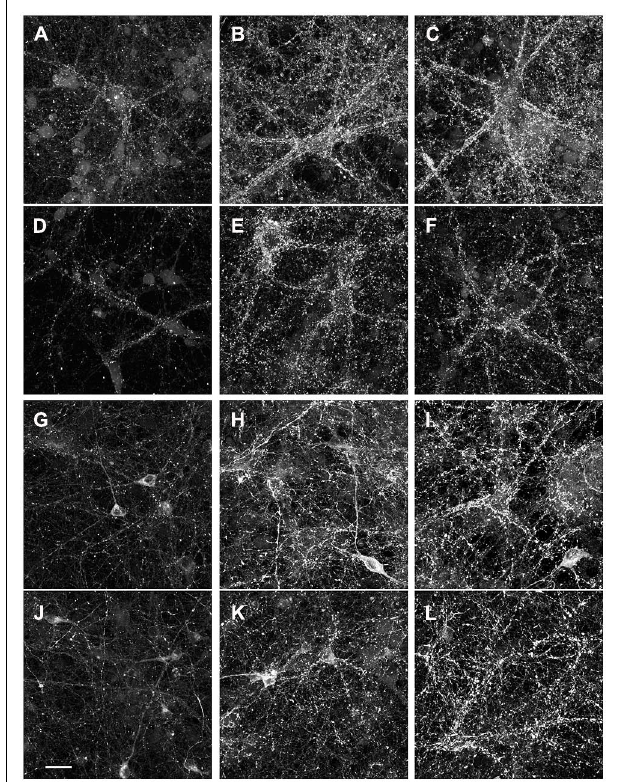
FIGURE 5 | Comparison of synaptic marker expression. Mature neurons from wt (A–C, G–I) and MeCP2-/y (D–F, J–L) were assessed immunocytochemically on DIV 12, DIV 18 and DIV 21 for expression of the presynaptic marker synaptophysin (A–F) and the marker of GABAergic neurons GAD-67 (G–L) . Scale bar: 20 μ